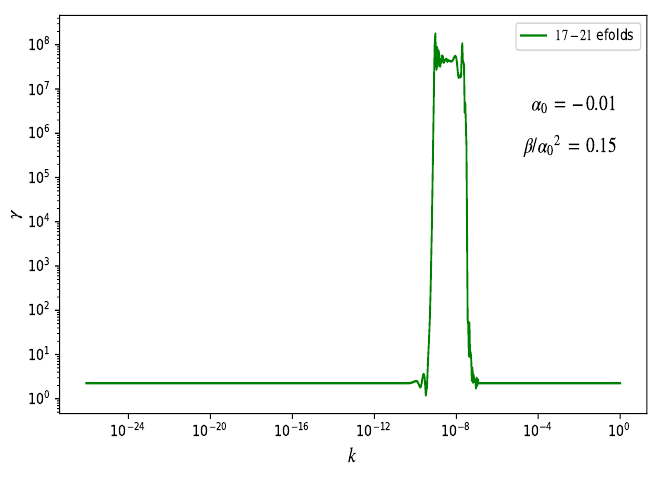
Figure 2 . This figure shows the top-hat plot of γ against wavenumber k , resulted from the α behavior plotted in Fig. 1. The instability appeared in scales k = e − 21 H − e − 17 H would be corresponded to the PBHs formation of masses 10 − 17 M (cid:12) − 10 − 13 M (cid:12) which can account for 10 − 100% of the dark matter